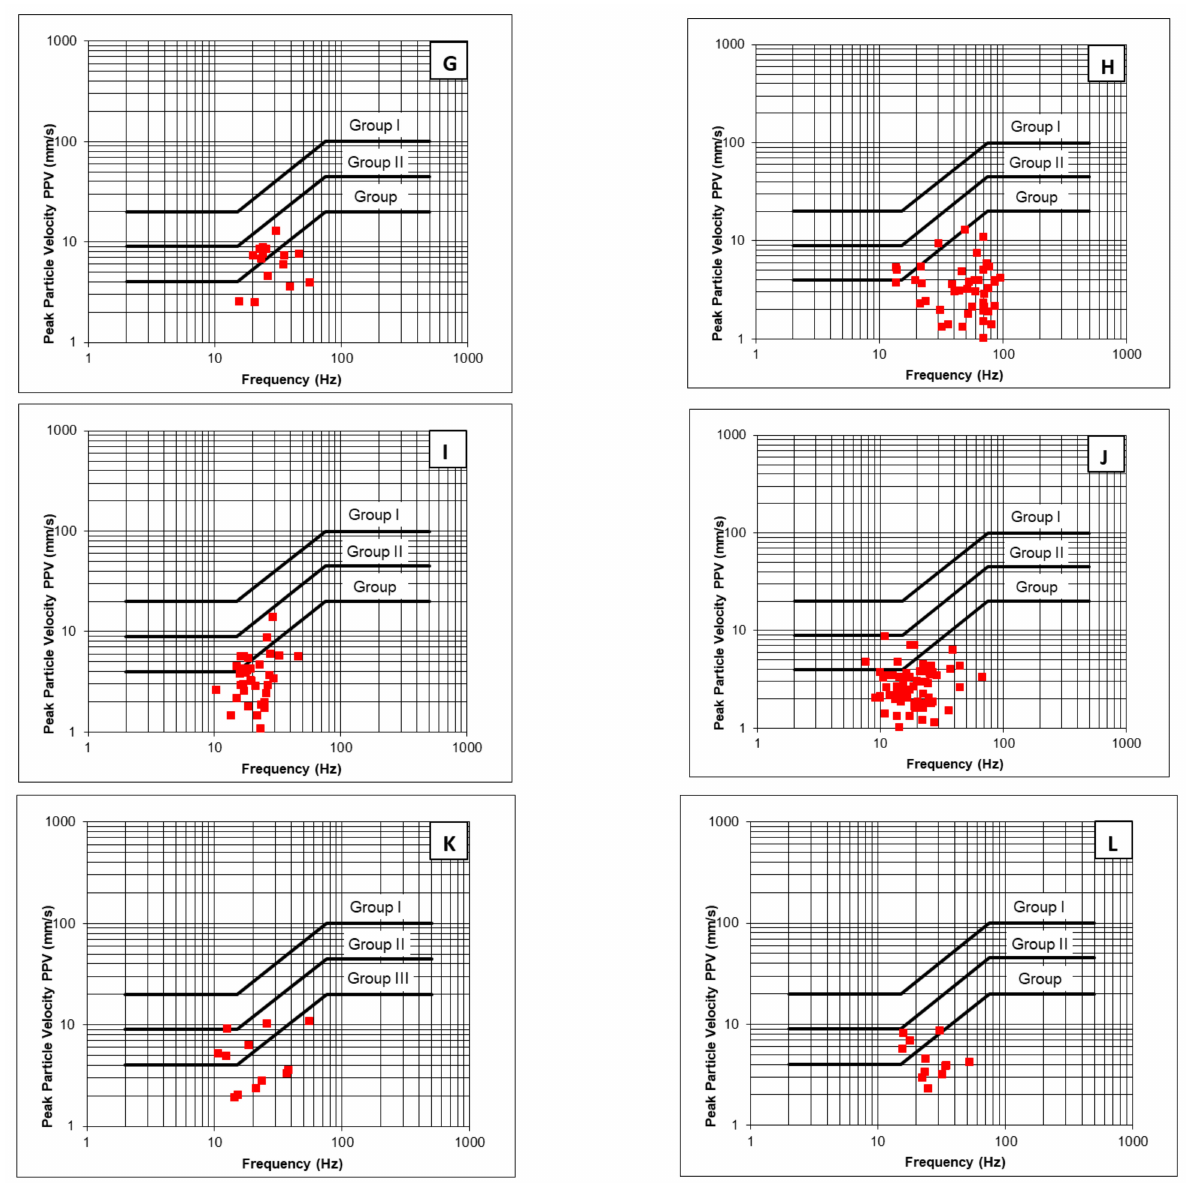
Figure 9. PPV-Frequency results from the 12 control